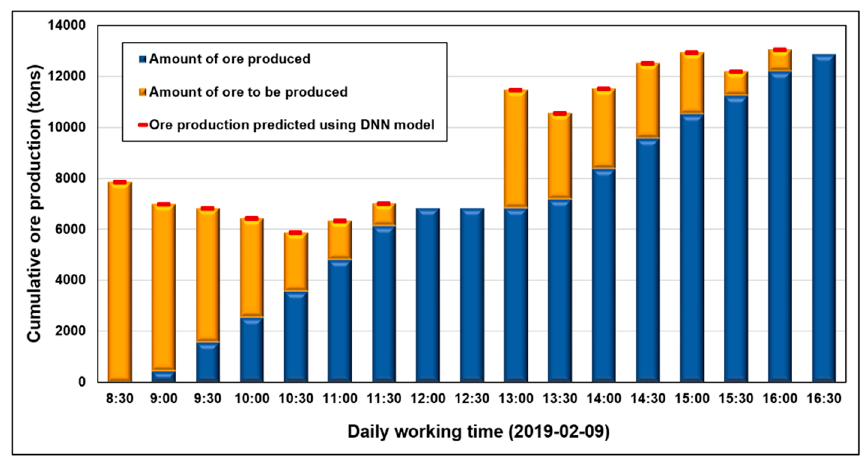
Figure 12. Ore-production predictions performed every 30 min on 9 February, 2019.